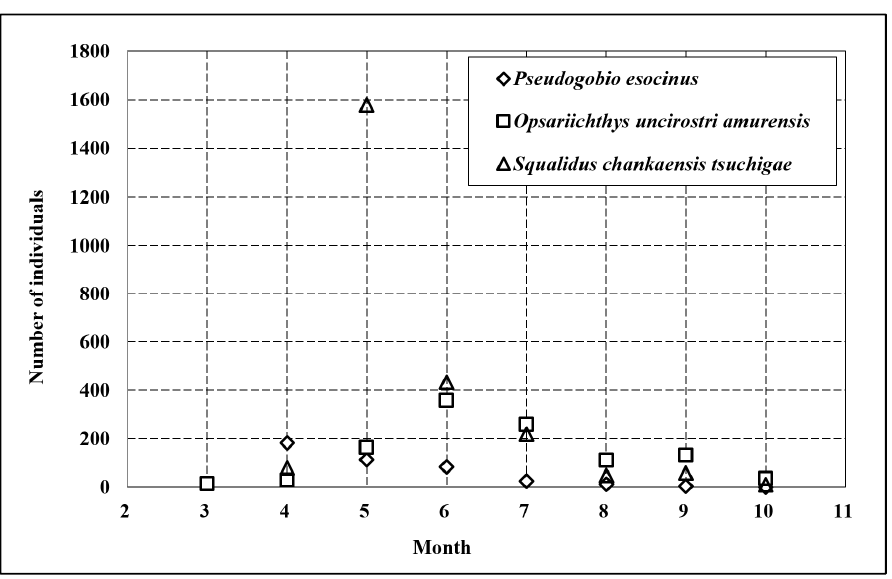
Figure 7. Number of individuals of three fish species that monthly passed by the fishway of Gangjeong-Goryeong Weir from March to October.